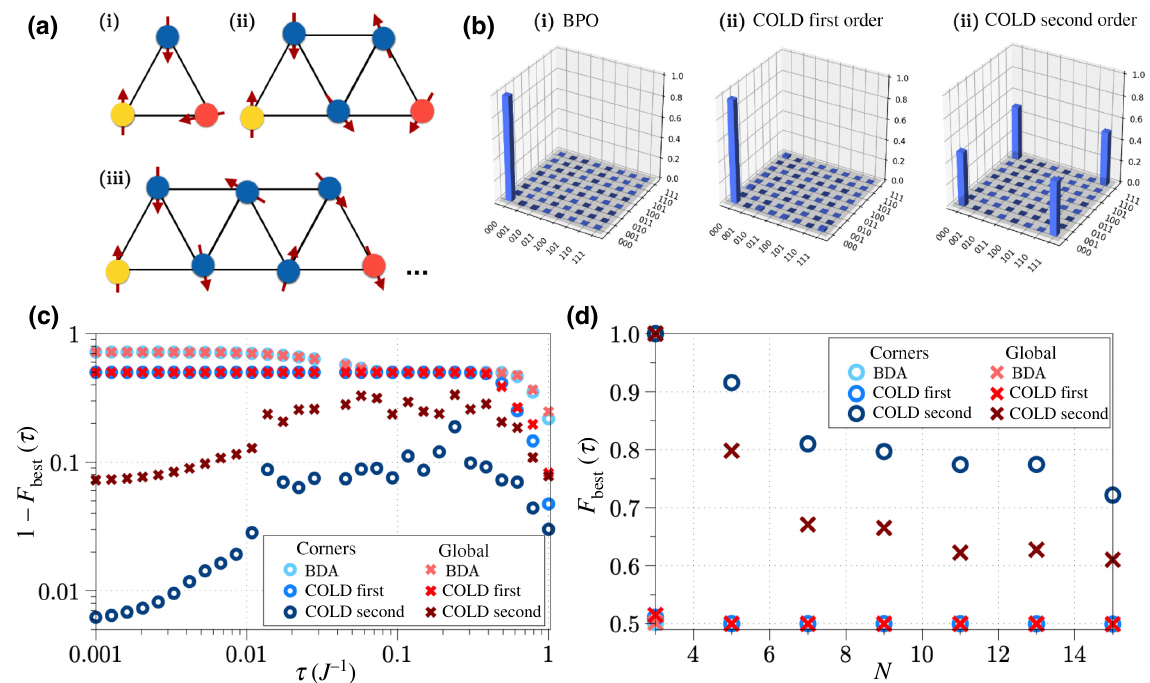
FIG. 7. GHZ state preparation in systems of frustrated spins. Spins are arranged in triangular formations as depicted in (a) for (i) three, (ii) five, and (iii) seven spins, with spins on the vertices and edges representing couplings. In the case of corner optimization, three separate optimizable drives are applied: one for the yellow corner spin, one for the red corner spin, and then a third drive for all of the blue spins in between. (b) Density matrix plots of the final state of a three-spin triangle after an evolution time τ = 0.1 J − 1 when optimized using (i) BDA, (ii) first-order COLD, and (iii) second-order COLD and corner optimization. (c) Final fidelities (plots show 1 − F ) of the GHZ state for the five-spin configuration depicted in (a)(ii) for an optimized global drive (red crosses) and locally driven corner spins (blue rings). (d) Final fidelities at driving time τ = 0.1 J − 1 for different system sizes N . In the global case we use ten total optimizable parameters with N k = 1 drive and N m = 10 time intervals, while in the corners case there are 30 total parameters as we increase to N k = 3 separate drives. The plotted fidelities are the best results of five optimizations for each data point.